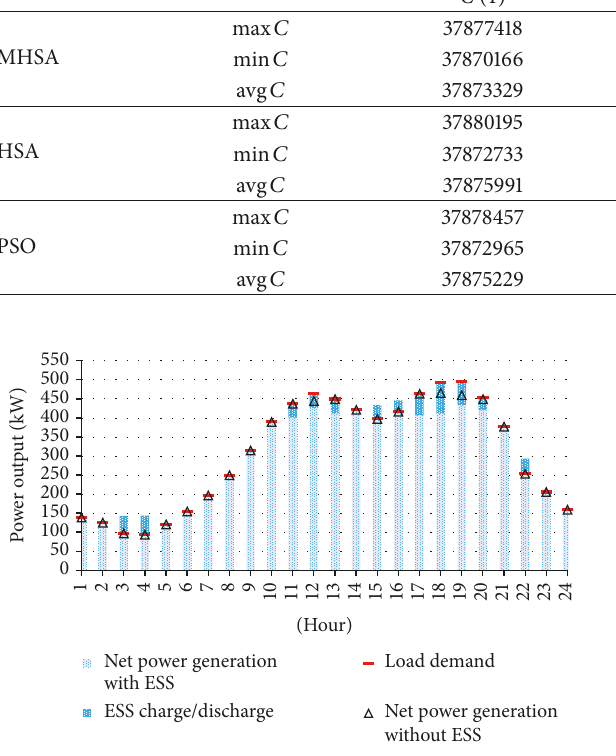
Figure 8: Supply and demand condition of Case 3.